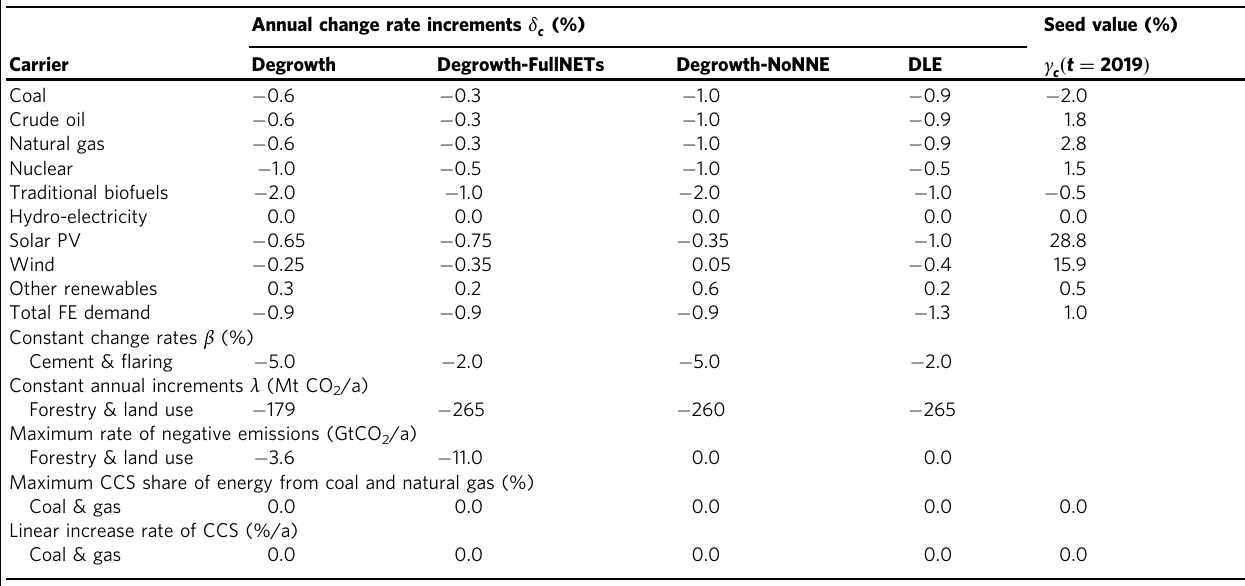
Table 3 Parameters for pathways with low energy-GDP decoupling.